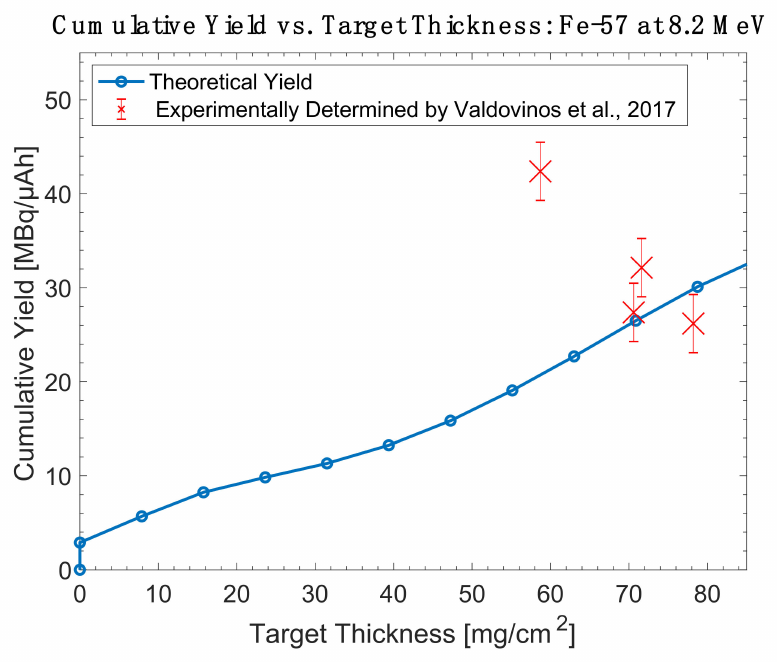
Figure 14. Thick target yield comparison between theoretical data and experimentally collected data for nickel-58 targets at ( a ) 15 MeV and ( b ) 16 MeV [14,23,26].